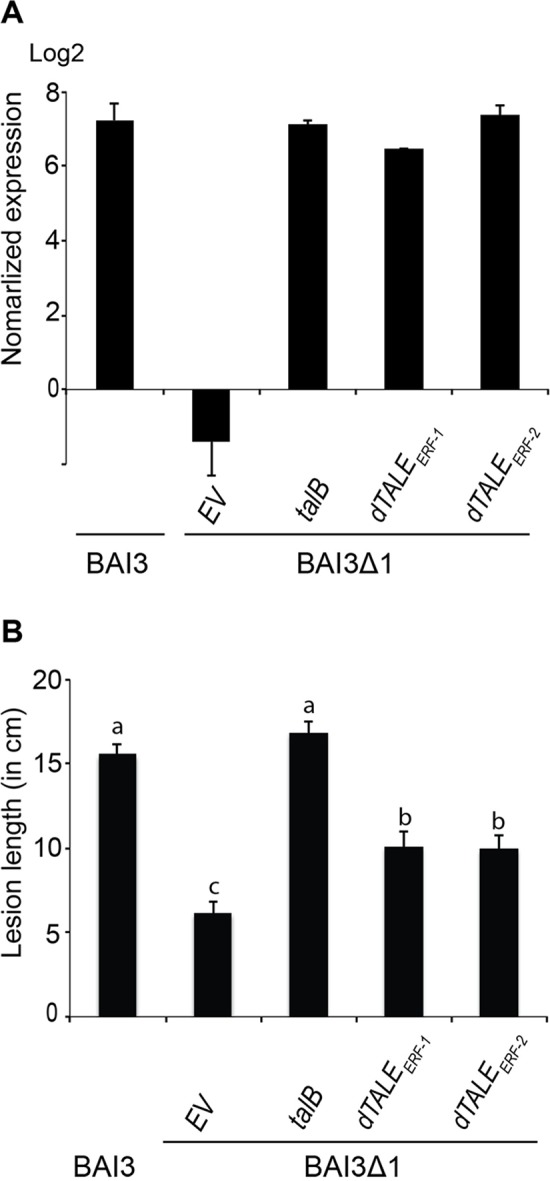
Mutation of talB in BAI3 results in a decrease of virulence partially complemented by the induction of OsERF#123.(A) BAI3 mutant strain BAI3Δ1 carrying plasmid-borne talBMAI1, dTALEERF-1 or dTALEERF-2 but not BAI3Δ1 carrying the empty vector (EV) induces OsERF#123. The expression level of OsERF#123 was evaluated by quantitative reverse transcription polymerase chain reaction (qRT-PCR) 24 hours after syringe infiltration of Nipponbare rice leaves. The wild type strain BAI3 was used as control. Gene expression was normalized against water inoculated leaves. Error bars represent +/- SD. (B) TalB and dTALEsERF act as virulence factors for Xoo strain BAI3. Rice leaves of IR24 were inoculated by leaf-clipping with BAI3Δ1 strains carrying an empty vector (EV) or derivatives carrying talBMAI1, dTALEERF-1, or dTALEERF-2. Lesion length was measured at 15 days after inoculation (dai). Data are the mean of at least 16 measurements. Error bars represent +/- SE. Bars with same letters are not statistically different based on a Tukey’s multiple comparisons test (α = 0.05).